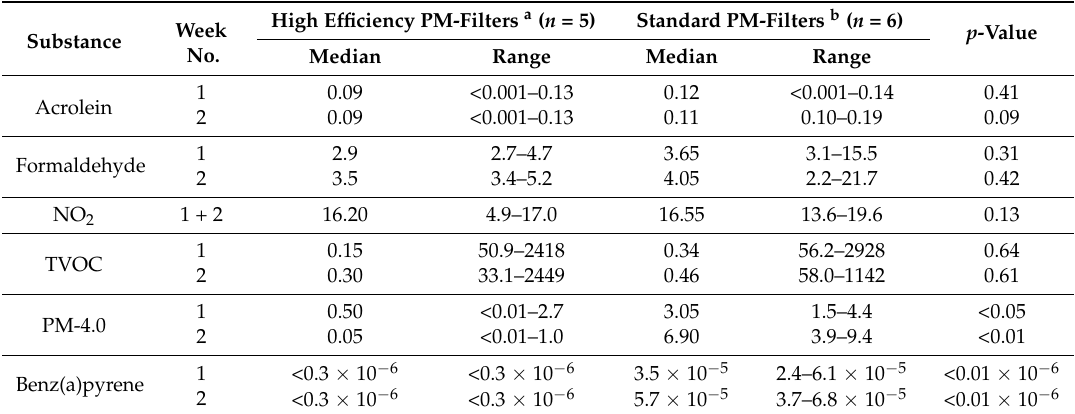
Table 4. Comparison of IAQ parameters on locations arranged by type and efficiency of installed filters in air treatment systems.